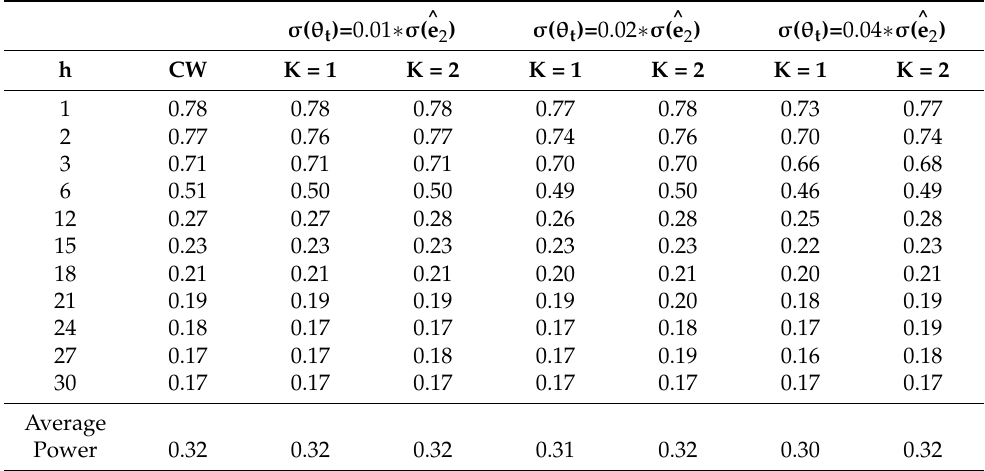
Table 8. Power comparisons between CW and WCW tests with nominal size of 10%, considering DGP1 and a small